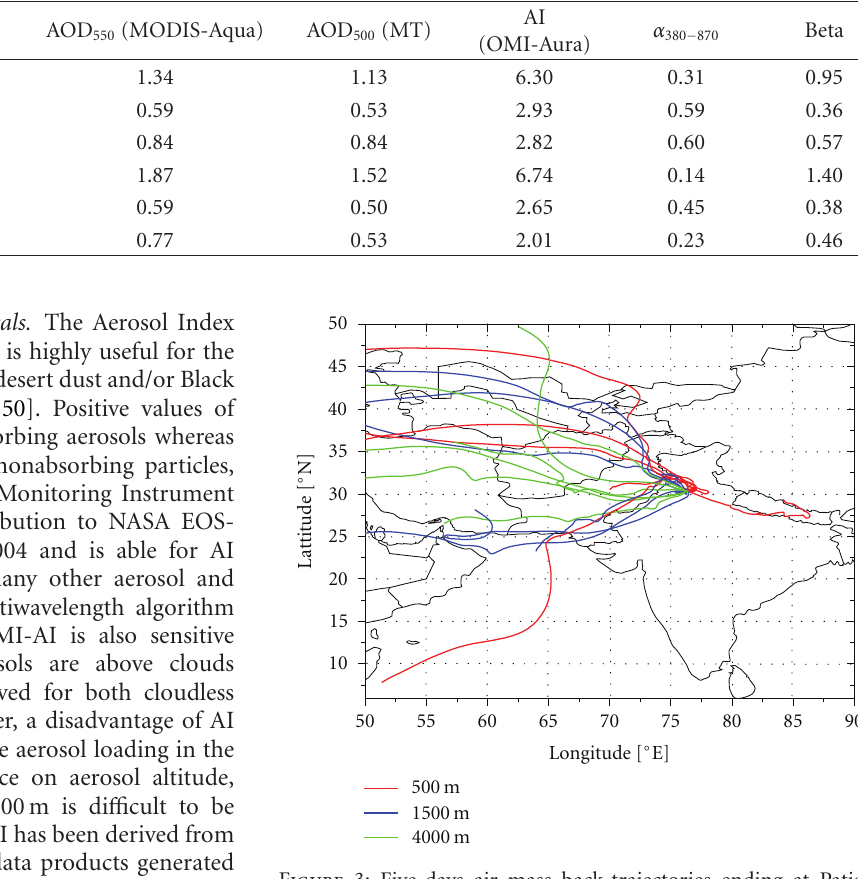
Figure 3: Five-days air mass back-trajectories ending at Patiala (HYSPLIT model) at three di ff erent altitudes, 500 m, 1500 m, and 4000 m, on the six dusty days (see Table